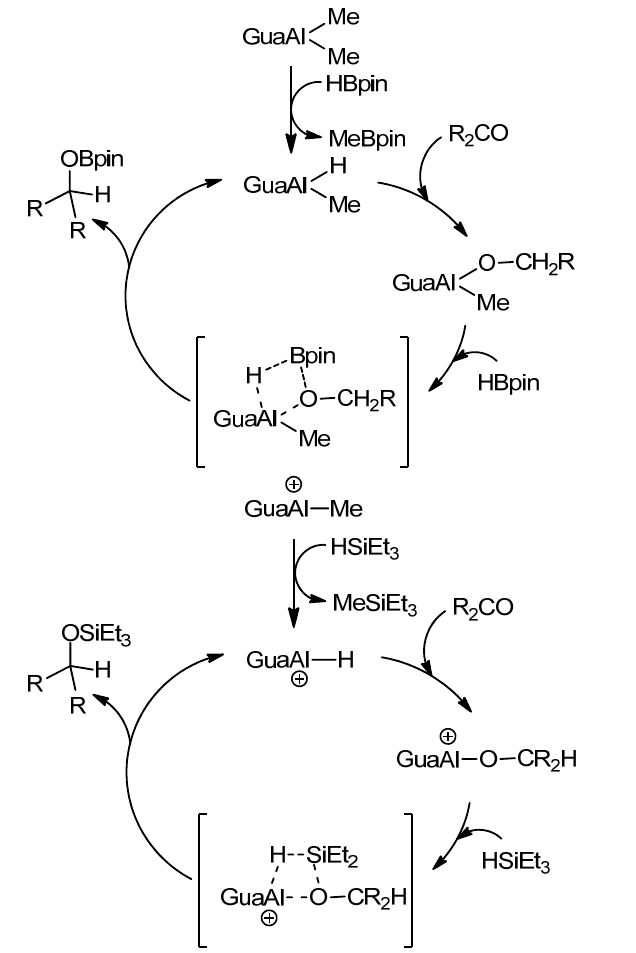
Figure 21. Hydroboration and hydrosilylation of ketones by aluminum hydride compounds. Likewise, the dinuclear complexes of the type 30 (Figure 22) are efficient catalysts for the ring-opening polymerization of L-lactide and ε -caprolactone [78].